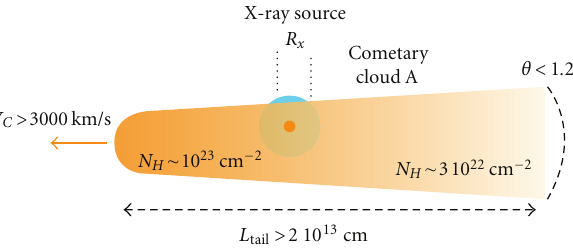
Figure 2: Structure of the absorbing cloud as obtained from a Suzaku observation of NGC 1365. The estimates are based on the hypothesis of Keplerian motion, and on a black hole mass of 2 × 10 6 M (cid:3) [45]. The cloud size is not in the correct scale: the tail is much longer when compared with the source size, which is of the order of a few 10 11